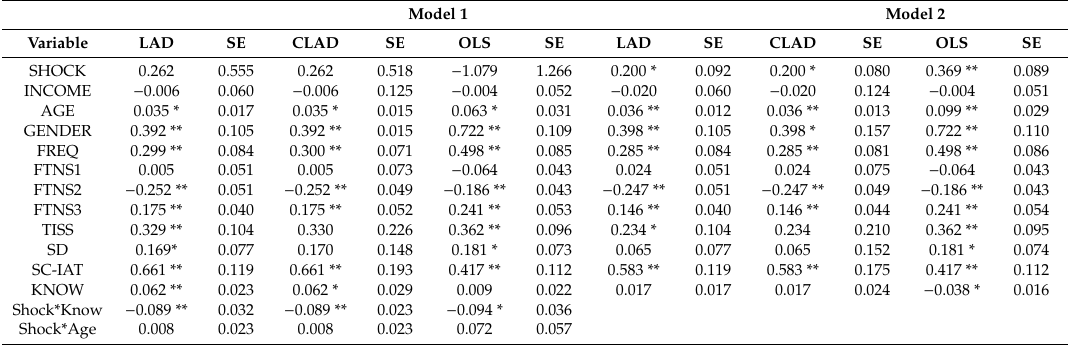
Table 8. Censored and uncensored regression with (Model 1) and without (Model 2) interactions ( n =